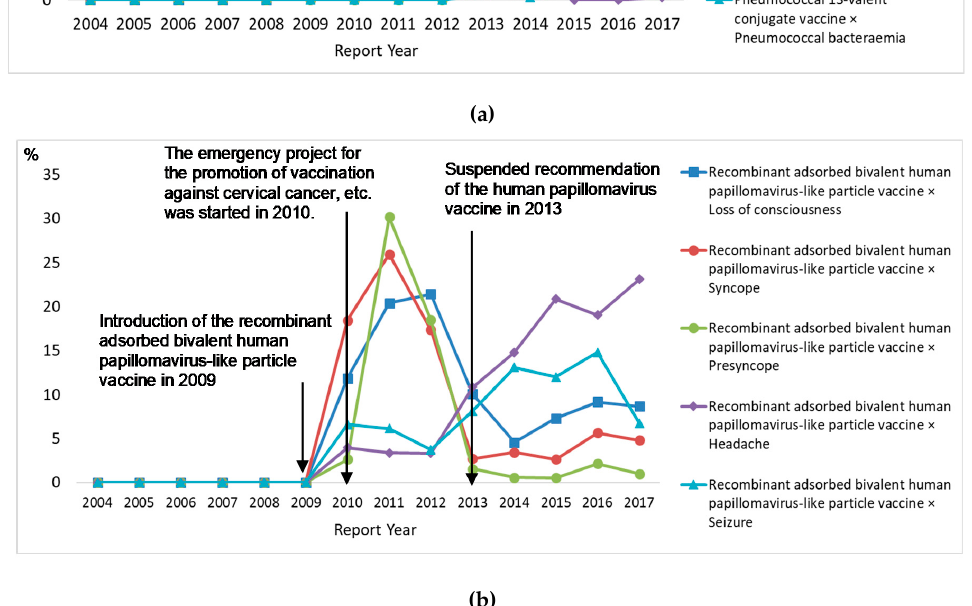
Figure 4. Time trend of five frequently reported vaccines–reaction pair according to age group. ( a ) Children <10 years old. ( b ) Children 10–19 years old.